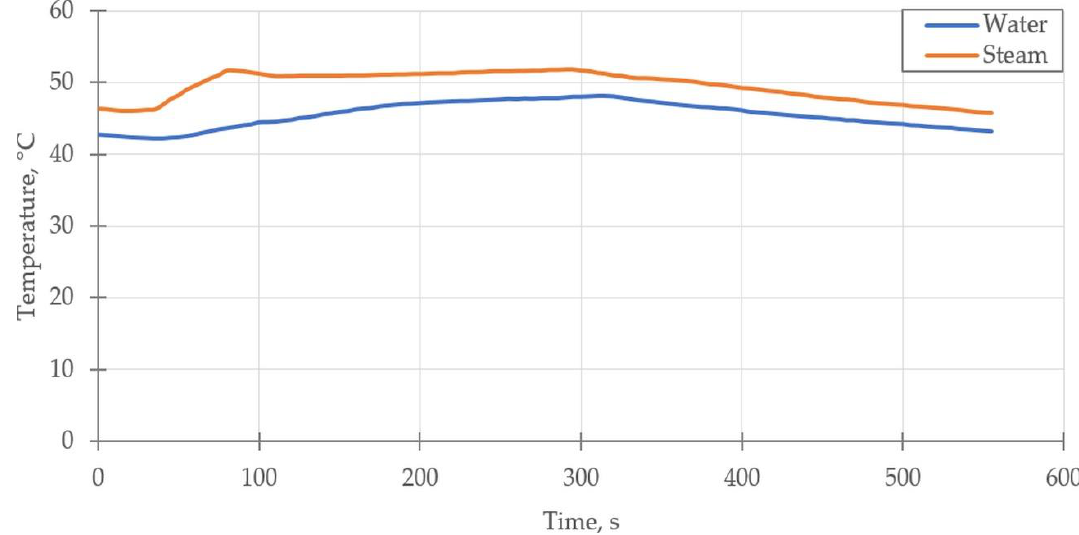
Figure 7. Temperature of the free space of the bed (T9) during desorption.